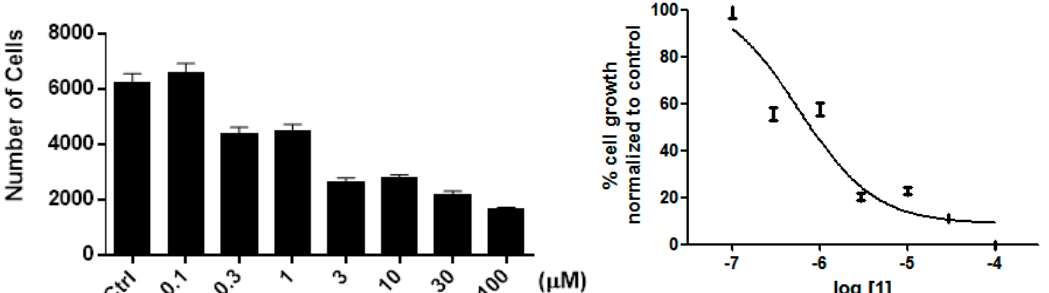
Figure 5. Left : Cell growth inhibition in MDA-MB-231 cells after 48 h of incubation with compound 1 at the reported concentration; Right : dose-response curve of log[ 1 ] vs. % cell growth normalized to control. Values indicate the mean of three independent experiments. Error bars show the corresponding standard deviation values.